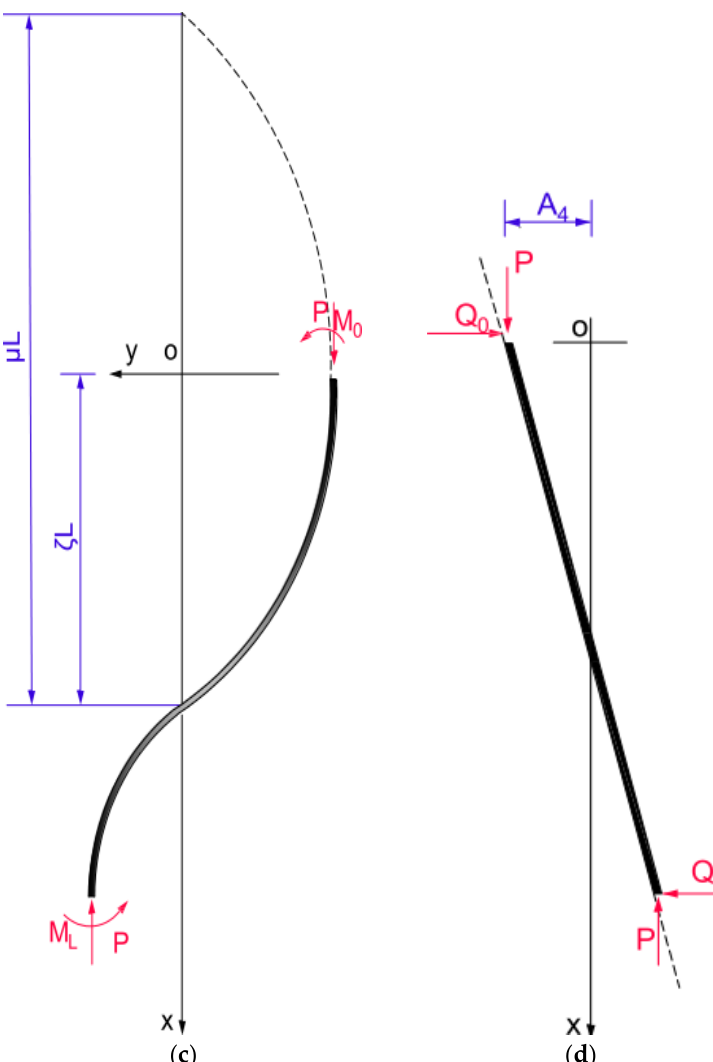
Figure 3. The lateral deflection decomposition diagram of the column subjected to the axial force and shear moment: ( a ) Before deformation; ( b ) after deformation; ( c ) sine curve; and ( d ) sloping straight line.